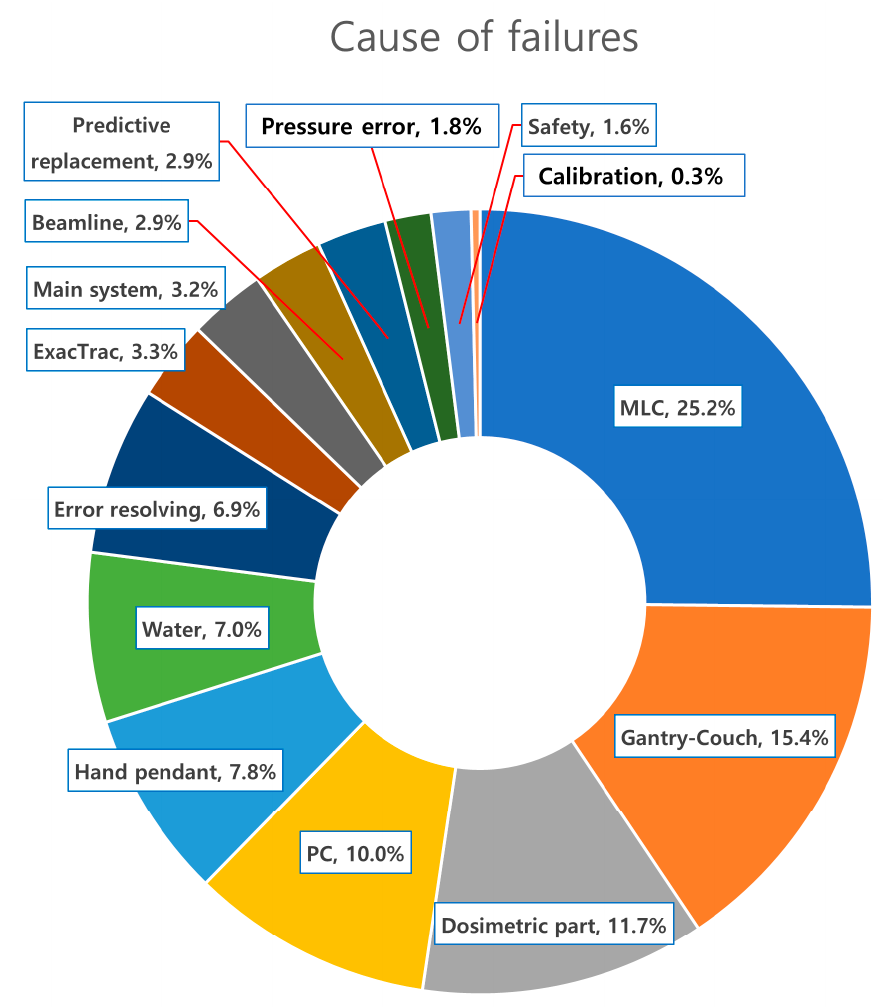
Figure 2. LINAC causes of failure for Novalis in our